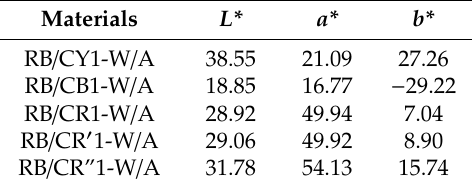
Table 2. CIELab values of RB / CY1-W / A, RB / CB1-W / A, RB / CR1-W / A, RB / CR (cid:48) 1-W / A and RB / CR”1-W / A.